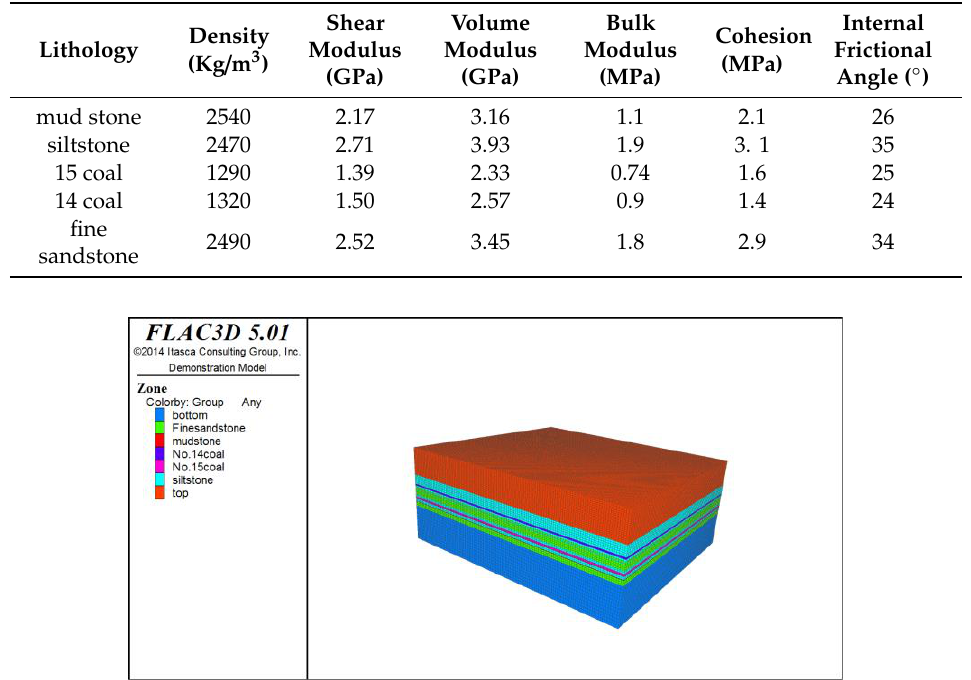
Table 2. Attribute parameters of the main rock strata in the 051508 working face [22].